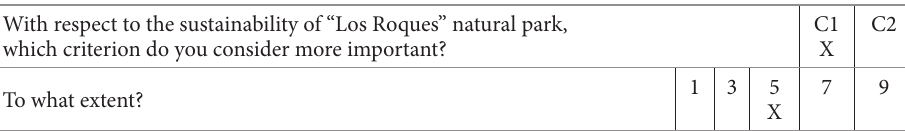
Table 2. Sample of questionnaire used for criteria comparison C1: Water quality vs C2: Landscape